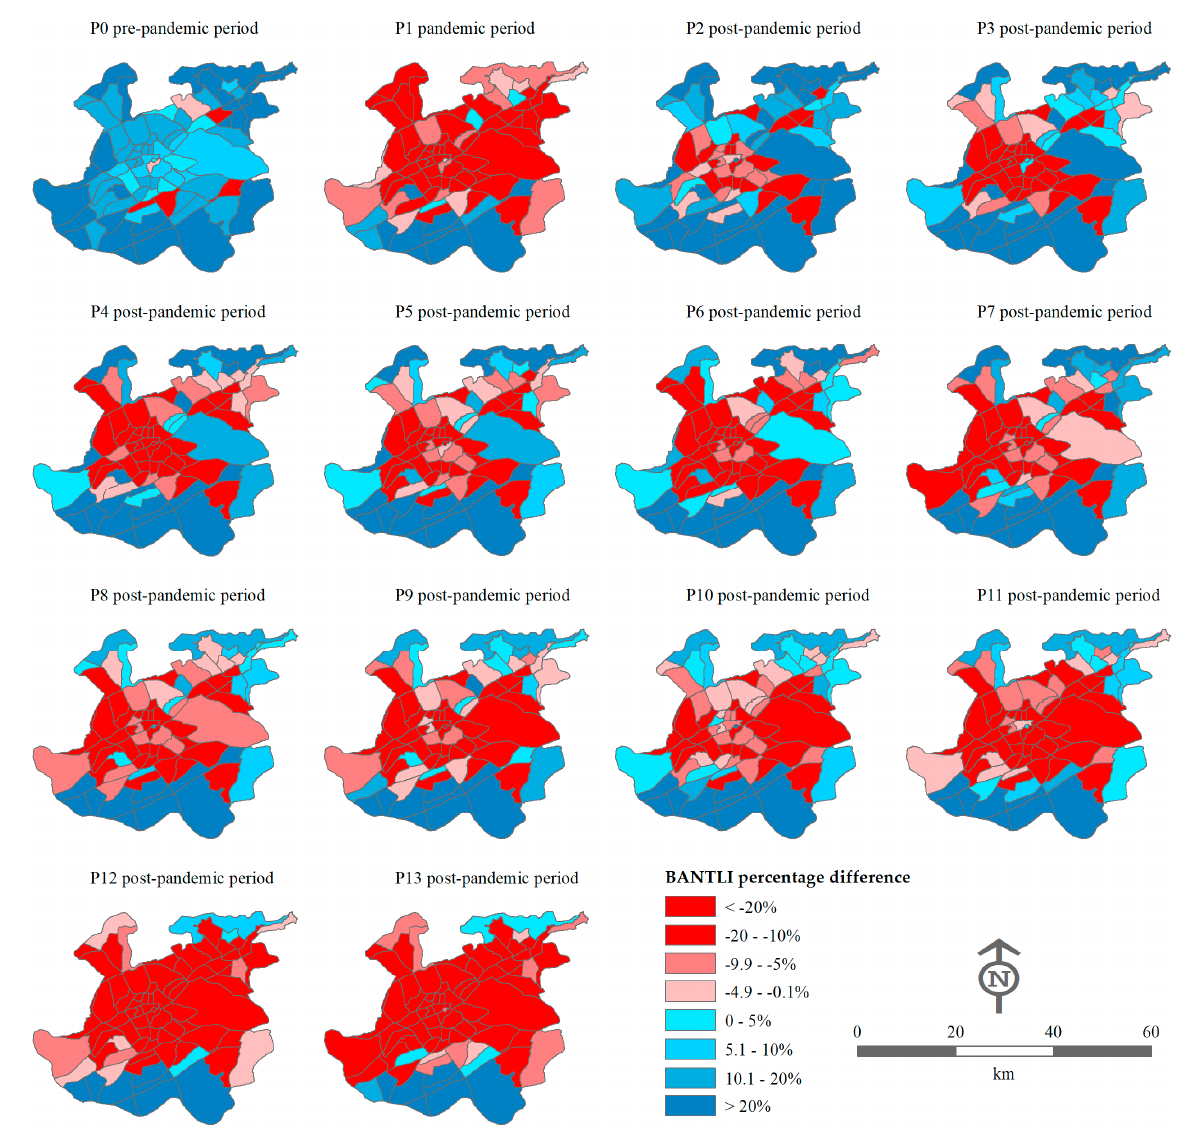
Figure 11. Maps of percentage difference in BANTLI radiance for the pre-pandemic (P0), pandemic (P1) and post-pandemic (P2 to P13) periods in Makkah at the ward level.